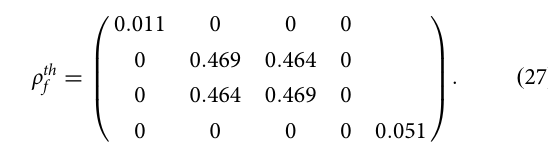
Fig. 6 Reconstruction of the density matrix. a The complete pulse sequences for initialization, entanglement generation, geometric phase labeling, and (cid:1) (cid:5) (cid:1) (cid:3) (cid:1) element. Microwave, MW; radio-frequency, RF. P denotes pulse. b The oscillation of the echo amplitude acquired (cid:1) detection for extracting the 1 e 0 n 0 e 1 n by quadrature detection and the corresponding Fourier transform spectrum. The solid lines and dash lines represent the real (in-phase) and imaginary (quadrature) component, respectively. Imag denotes the imaginary part. c , d The reconstructed density matrix shown in the basis of hybrid-spin system. The zero elements are displayed with green